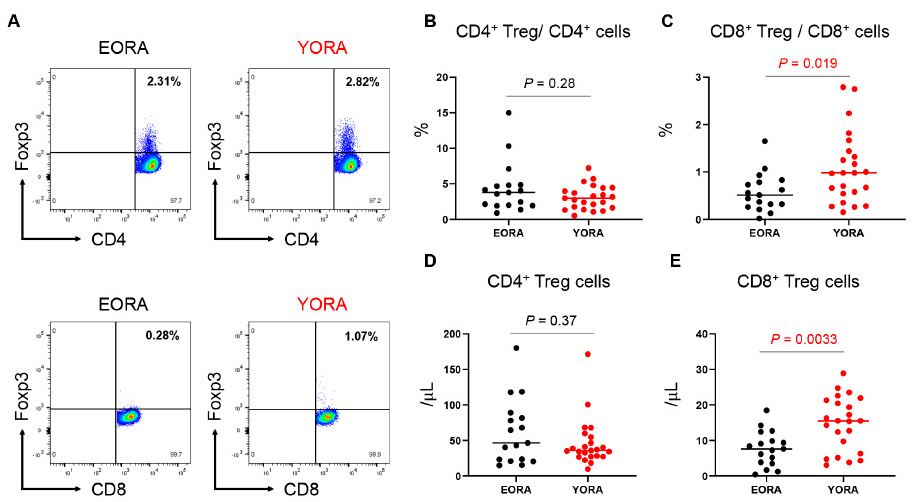
Figure 3. CD8 + regulatory T cells (Tregs) are deficient in elderly-onset rheumatoid arthritis (EORA). Number of CD4 + and CD8 + Tregs, and proportions of CD4 + and CD8 + Tregs to CD4 + and CD8 + T cells, were determined using flow cytometry (Figure 2 shows gating strategy). ( A ) Representative dot plots of CD4 + and CD8 + Tregs in patients with EORA and YORA. Proportions (%) of ( B ) CD4 + Tregs to CD4 + T cells and ( C ) CD8 + Tregs to CD8 + T cells. Comparison of absolute number of ( D ) CD4 + Tregs and ( E ) CD8 + Tregs in peripheral blood (/ µ L) between EORA ( n = 17) and YORA ( n = 23). ( B ‒ E ) Data are shown as dot plots and medians, and statistical signi fi cance was determined using unpaired two-tailed Student t -tests or Mann–Whitney U tests. EORA, elderly-onset rheumatoid arthritis; YORA, young-onset rheumatoid arthritis.